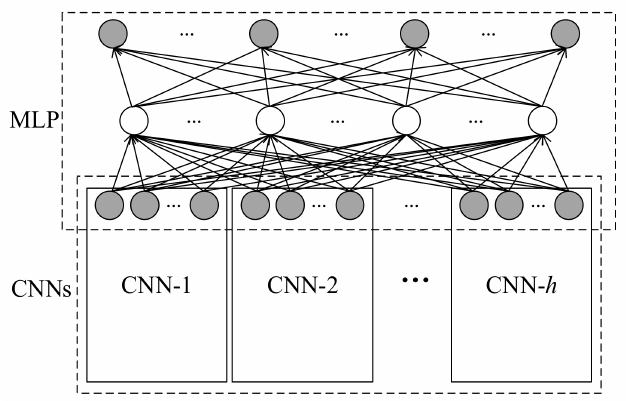
Figure 4. The architecture of predictive deep convolutional neural network